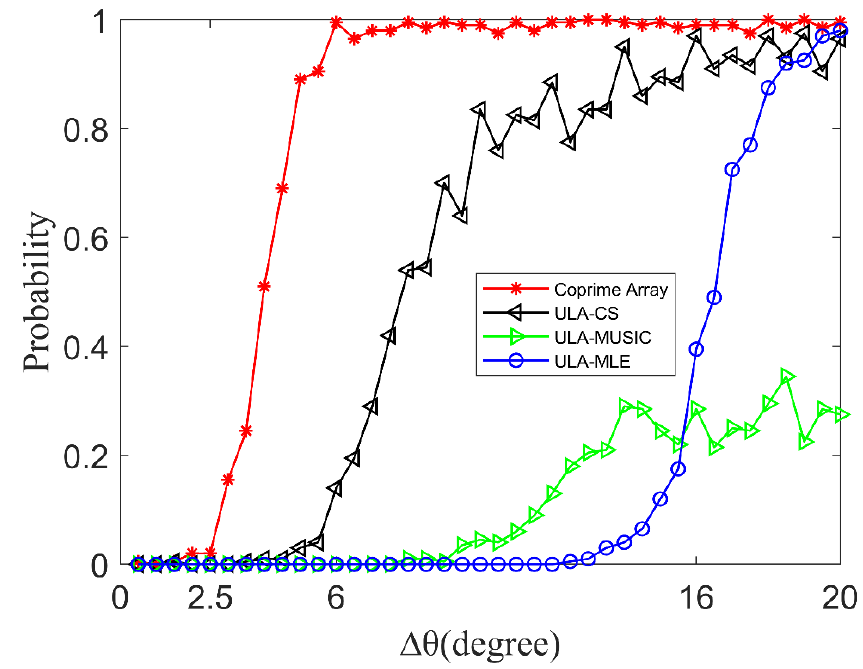
Figure 8. The relationship between the probability that can be correctly estimated and the direct-signal DOA difference between two CCBSs when there are 4 co-frequency base stations.